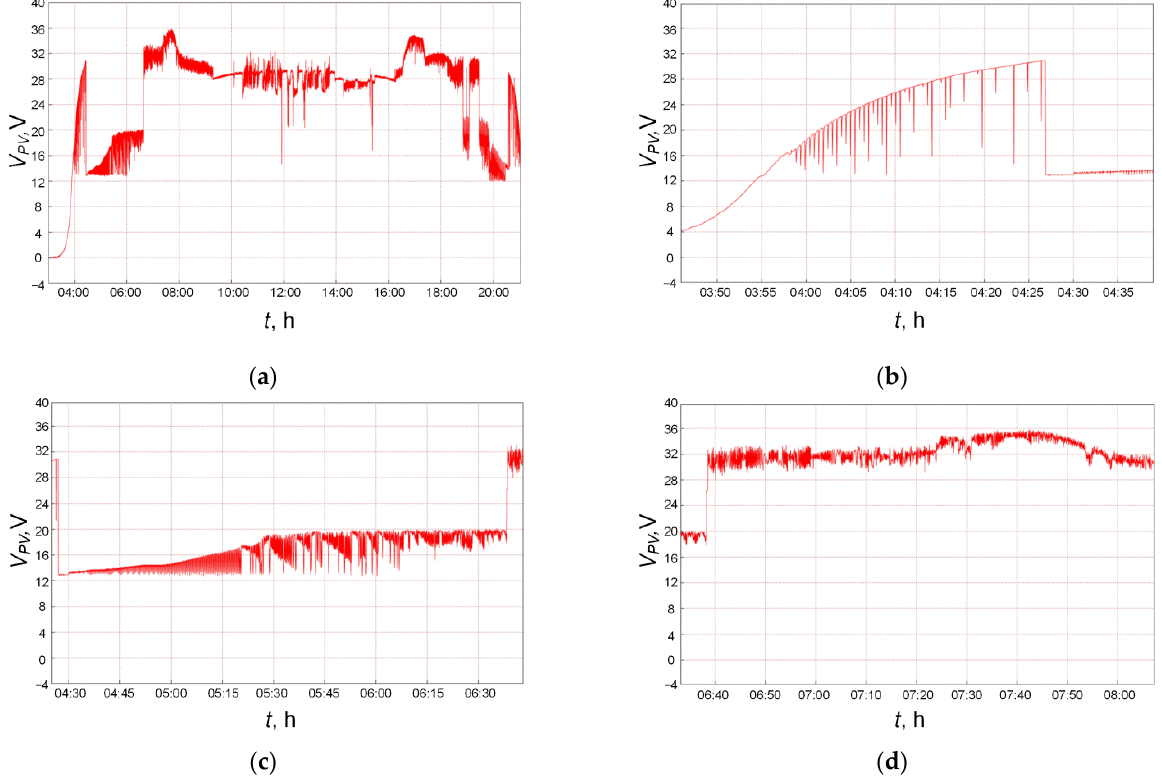
Figure 14. V PV vs. t of the PV module loaded by Skymax inverter: ( a ) daily characteristic; ( b ) beginning period of daily characteristic at low solar irradiance and low load; ( c ) start of inverter under nominal load; ( d ) nominal operation of inverter with active MPPT function.